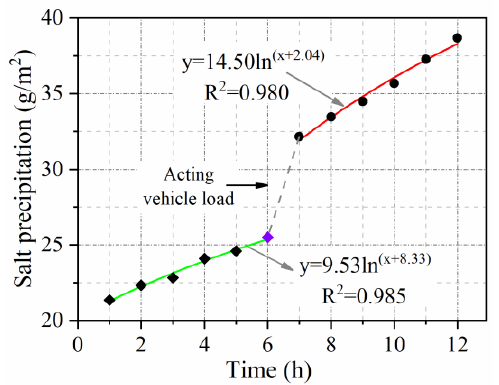
Figure 15. Effect of vehicle load on salt precipitation.